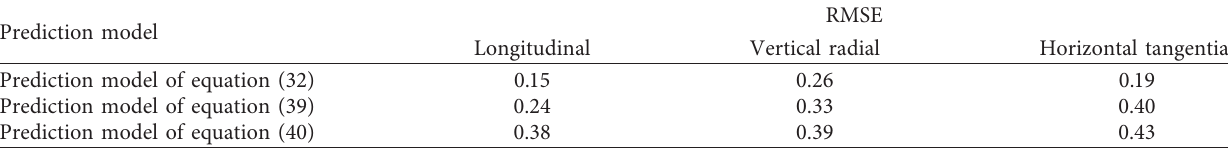
Table 4: Root-mean-square error (RMSE) of the